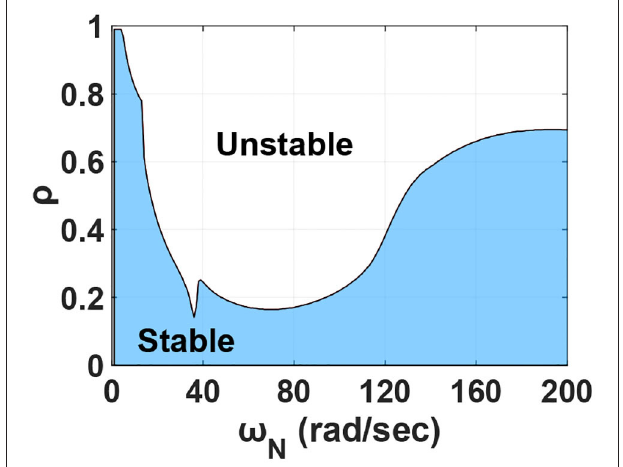
FIGURE 11 | Stable margin considering shake table dynamics for RTHS of the simplified BMD system.